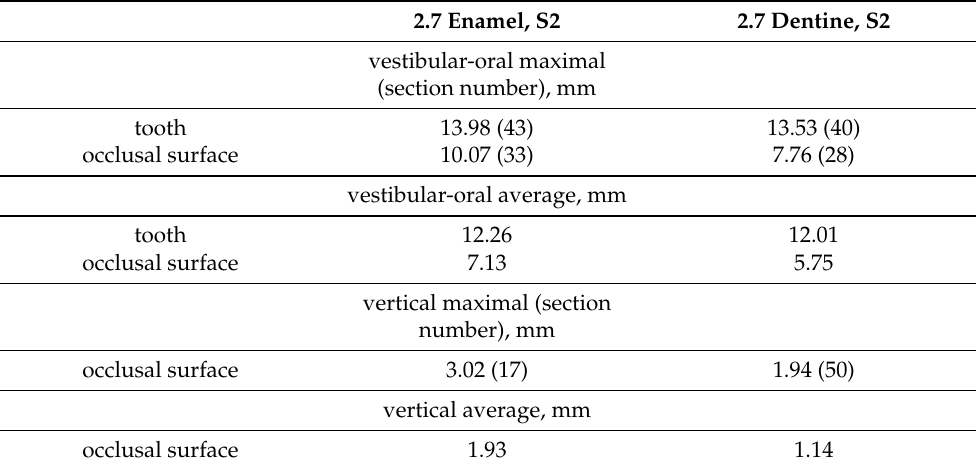
Table 1. Odontometric parameters for enamel and dentine, upper left second molar,